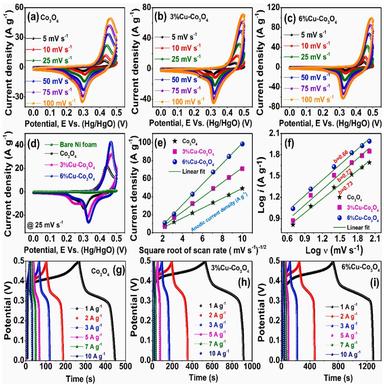
CV curves at different scan rates (5–100 mV s − 1 ) (a–c), comparison of CV curves at 25 mV s − 1 (d), anodic peak current density vs. square root of scan rate plot (e), log (i) against log (v) plot (f), and GCD curves at different current densities (1–10 A g− 1 ) (g–i) of undoped Co3O4 and Cu-doped electrodes.